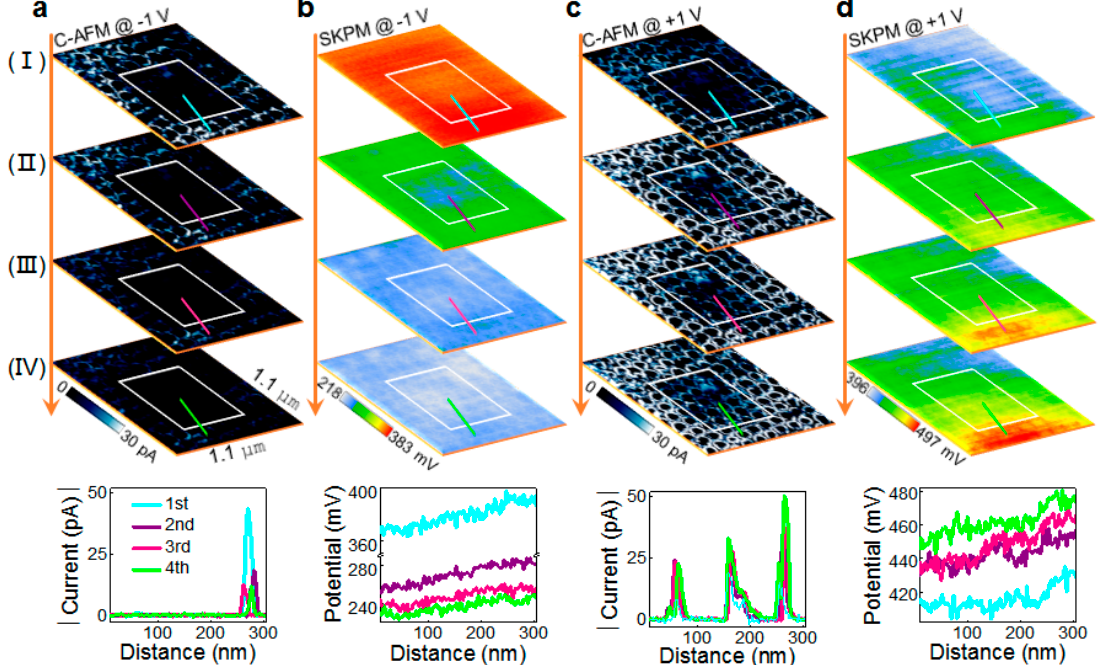
Figure 4. Current maps and surface potential images after multiple ± 1 V scans. Current maps scanned with ( a ) − 1 V and ( c ) +1 V four times (I–IV) in a region initially written with +6 V (outer)/ − 6 V (inner). Surface potential images taken right after the ( b ) − 1 V and ( d ) +1 V scans (I–IV). Insets at the bottom show the current and surface potential profiles along the section lines.